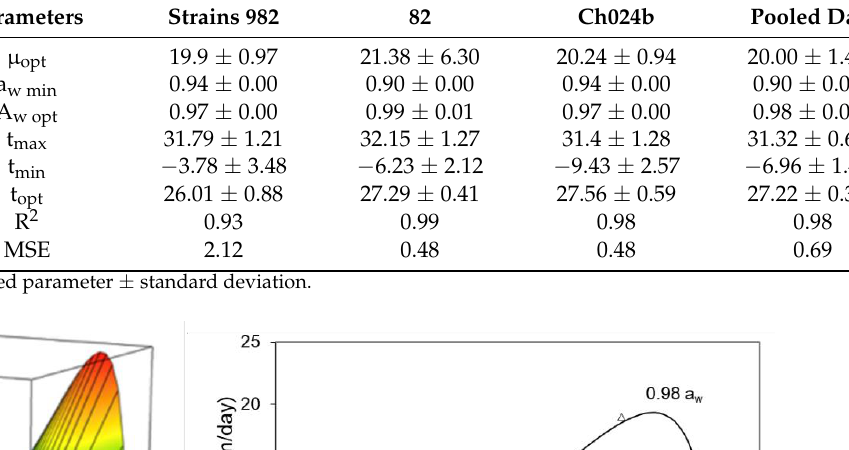
Table 3. Estimated parameter when the cardinal model was applied to the growth rates of the pooled data of the F. asiaticum strains (982, 82 and Ch024b) on a wheat-based medium.